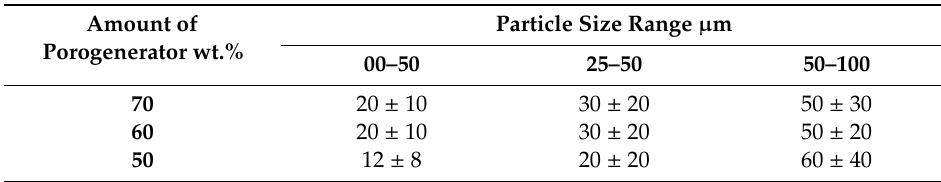
Table 2. Mean values and standard deviation of Feret diameter of ellipsoids adjusted to the pore shapes in leached samples with 50%, 60% and 70 wt.% of pore densities and particle sizes in 0–50, 25–50, and 50–100- µ m ranges.